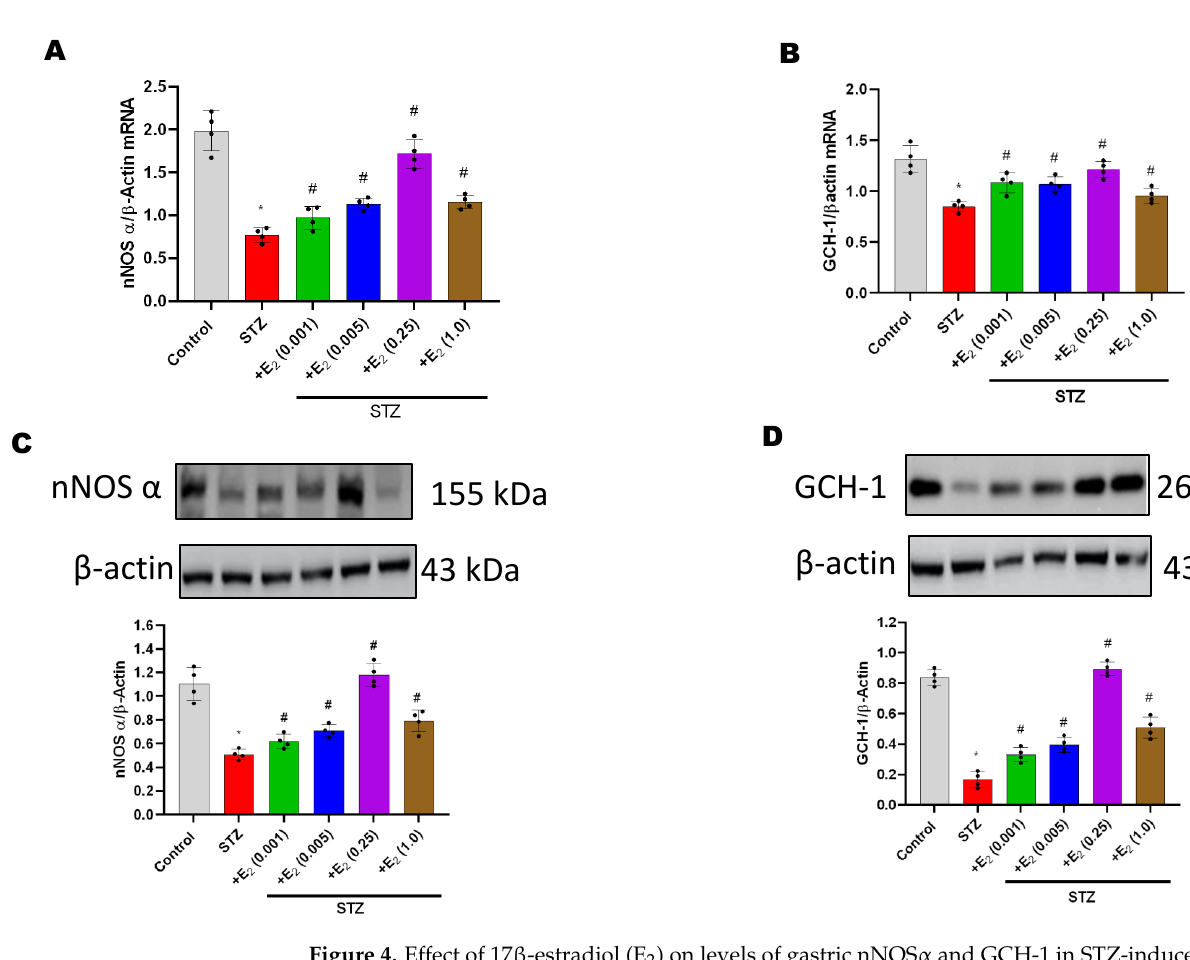
Figure 4. Effect of 17 β -estradiol (E 2 ) on levels of gastric nNOS α and GCH-1 in STZ-induced diabetic mice. Normalized mRNA levels ( A , B ), representative immunoblot, and densitometry analysis for nNOS α ( C ) and GCH-1 ( D ) are presented. Stripped blots were re-probed for β -actin. Data for levels of target genes or proteins were normalized to those of β -actin. Bar graphs depict ratios of levels of target genes or proteins to those of β -actin. Data were analyzed with one-way ANOVA using GraphPad Prism. Data are means ± SEM ( n = 4). * denotes p < 0.05; significantly different from healthy mice (Con). # denotes p < 0.05; significantly different from STZ-induced diabetic mice (STZ). Legends: neuronal nitric oxide synthase (nNOS), GTP cyclohydrolase 1 (GCH-1) streptozotocin (STZ), analysis of variance (ANOVA), standard error of the mean